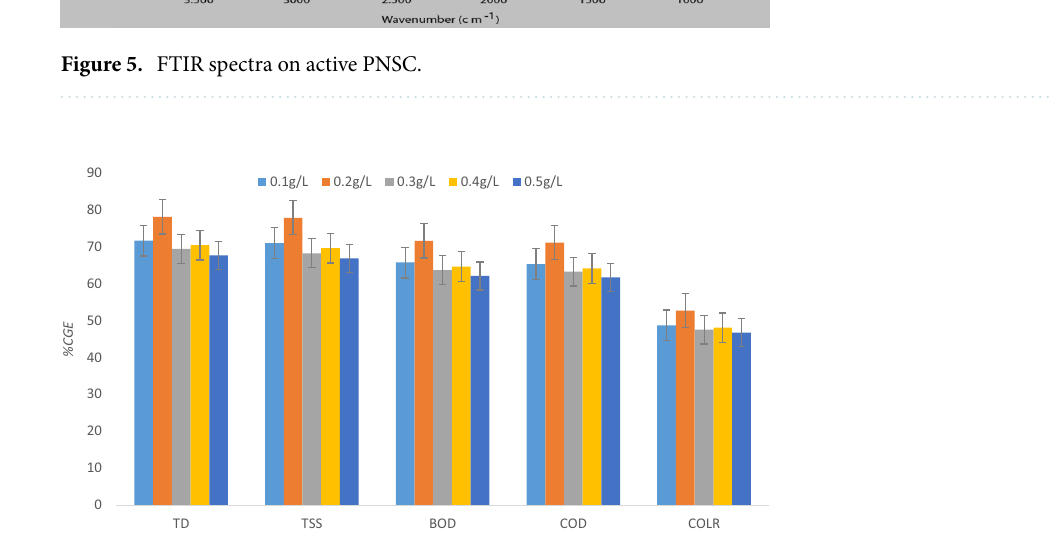
Figure 6. Effect of PNSC dose on pollutants elimination on AQEF at pH 7.9 and 60